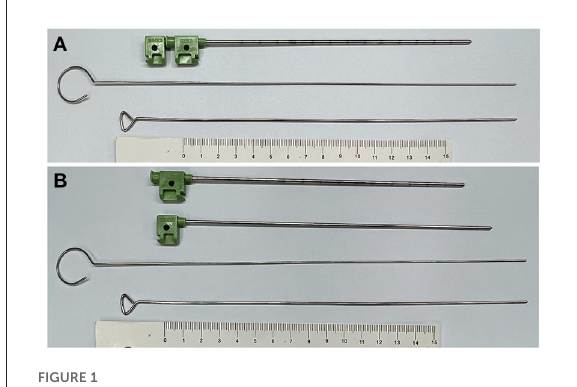
FIGURE1 Puncture kits. (A) PBC puncture kits. From top to bottom: head-blunted liver-biopsy needle with stylet in, thinner needle with a blunt head, needle with a wider diameter, ruler (for scale). (B) PBC puncture kits with the stylet out.